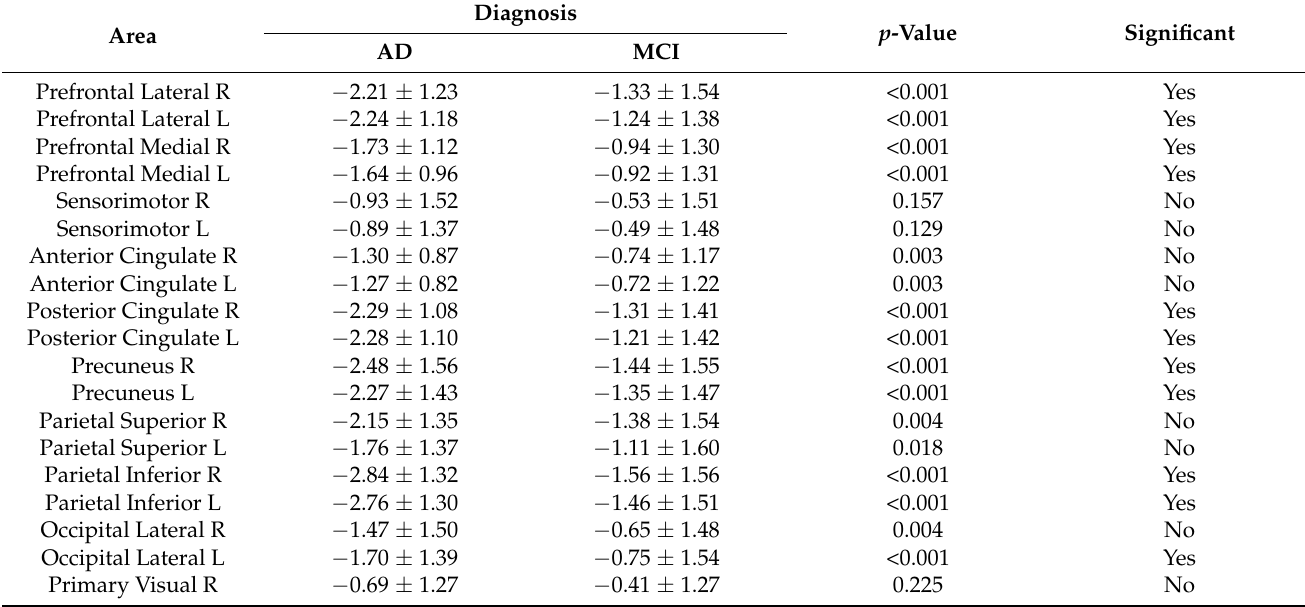
Table 3. Results of the univariate analysis. The values report the corresponding z score (mean ± std) for each area. Key to abbreviations: AD = Alzheimer disease, MCI = Mild Cognitive